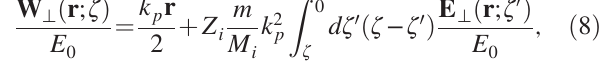
FIG. 1. Transverse lineouts of the wakefield W for the case of a bunch with a longitudinal flat-top distri- 1 ), and a Gaussian transverse distribution L bution ( k p b ¼ σ 0 . 015 ) propagating in an ion channel (Hydrogen ions, ( k p x ¼ n 0 ¼ 10 17 cm − 3 ) for different values of the bunch peak n i; 0 ¼ density. Transverse lineouts are taken at ζ ¼ − L refer to numerical results. Dashed black lines are the theoretical values given by Eq. (11). The orange dashed line is the transverse lineout of then ion density taken at ζ ¼ − L